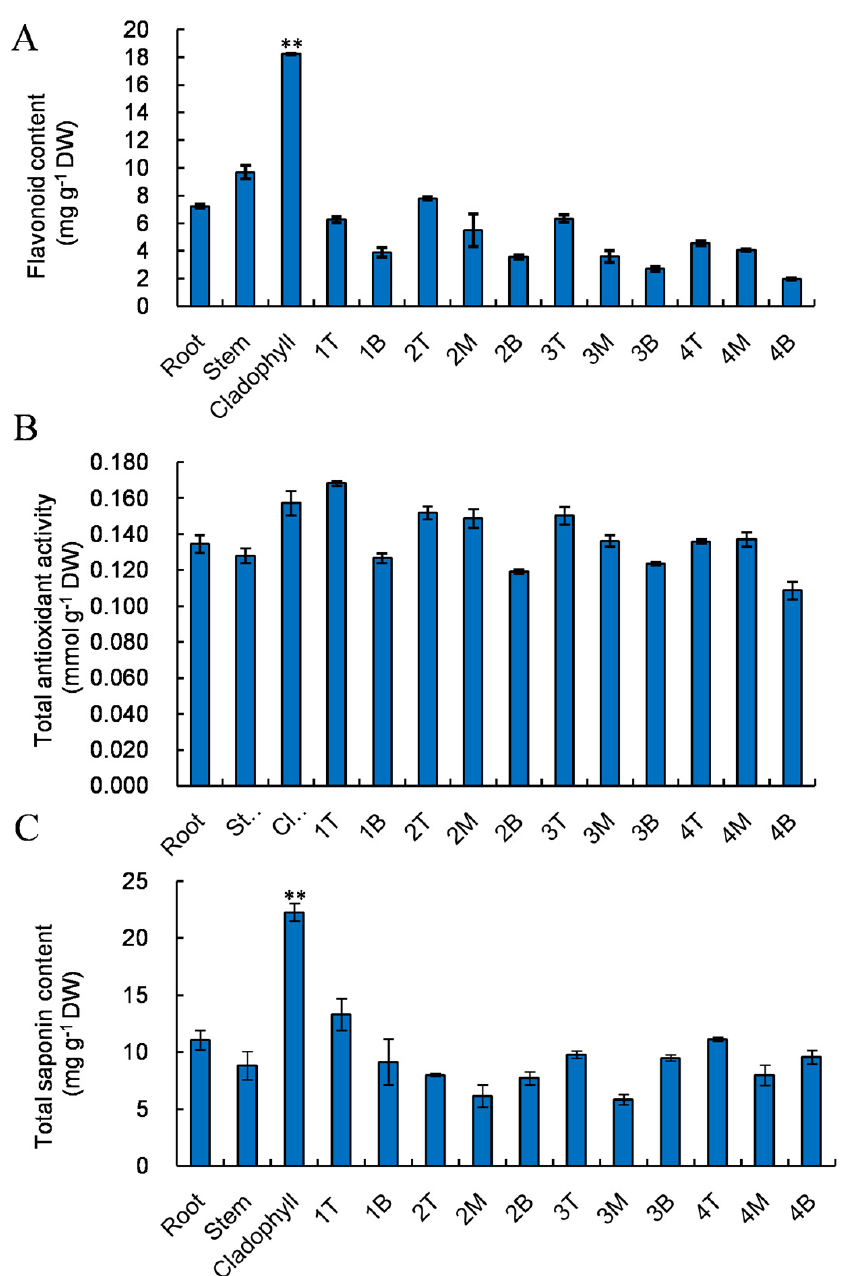
Figure 4. Total flavonoid content ( A ), antioxidant activity ( B ), and saponin content ( C ) in various asparagus organs and at different developmental stages according to the length of spears. Stage 1: 4–5 cm, Stage 2: 9–10 cm, Stage 3: 14–15 cm, and Stage 4: 19–20 cm. Parts of spears: T: top, M: middle part, B: bottom. The double asterisks indicate highly significant differences at level p < 0.01 (student’s t -test).